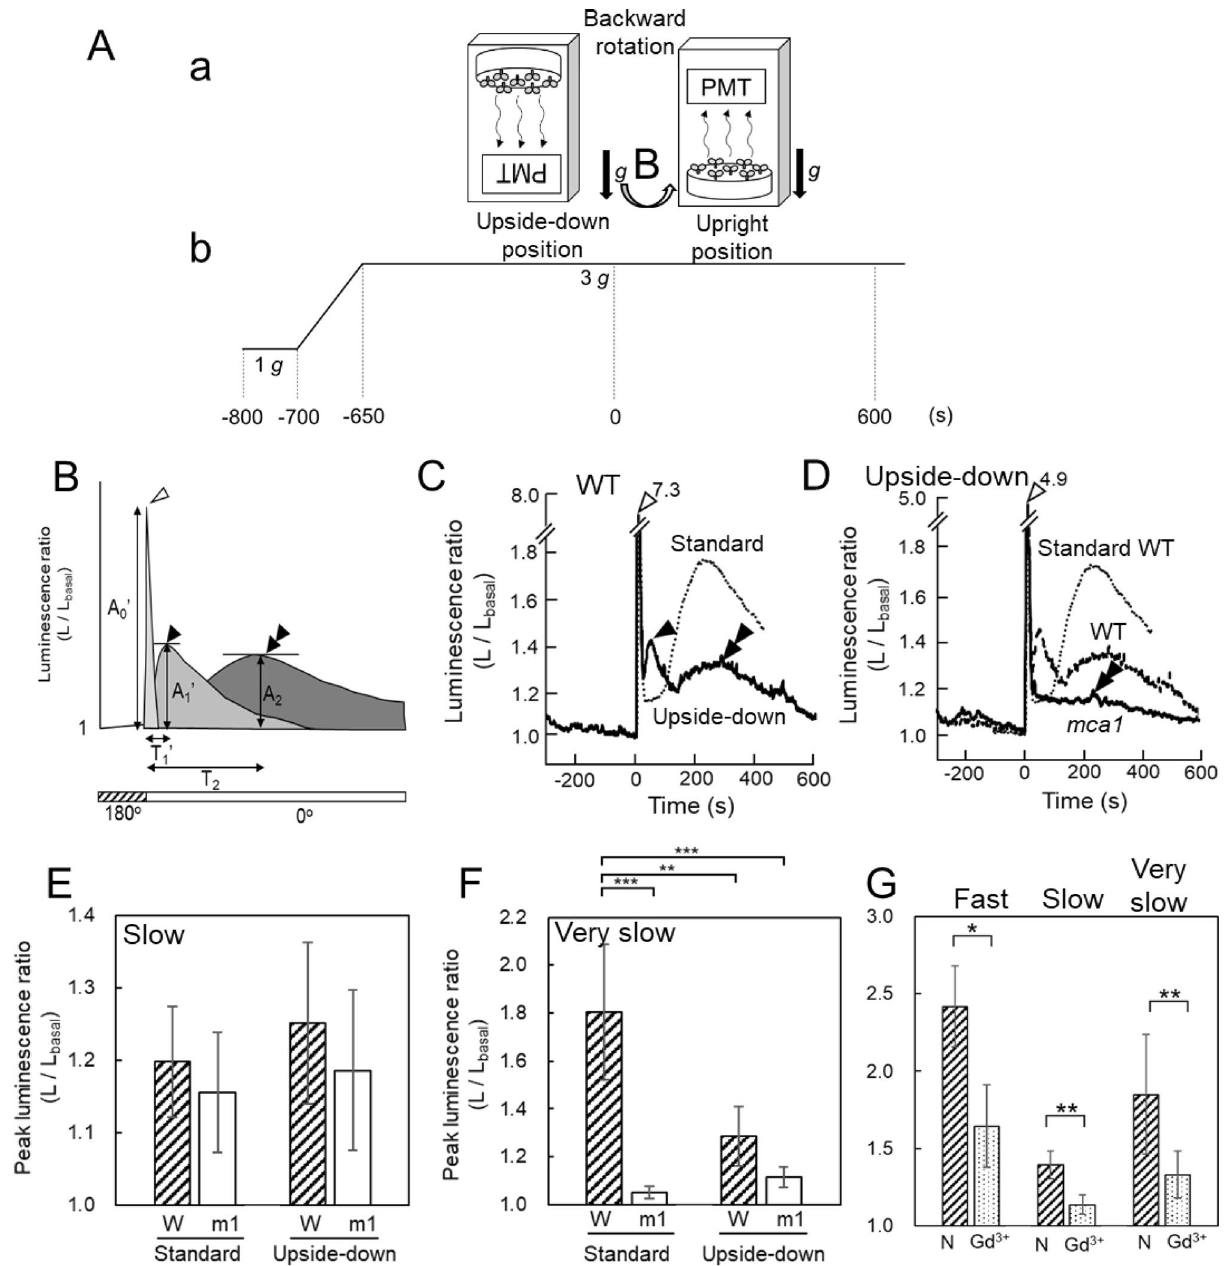
Figure 4. The very slow [Ca 2+ ] c -increase induced by backward rotation to the upright position in pre-rotated plants. A ( a ) The direction of Arabidopsis seedlings in the experimental protocol. ( b ) Time course of the magnitude of gravitational acceleration. The seedlings used for this experiment were kept in an upside-down position for 2–4 h prior to the experiment. ( B ) Schematic illustration of the time course of the change in the luminescence ratio induced by gravistimulation (backward rotation). The notation is the same as Fig. 1. ( C ) A typical [Ca 2+ ] c -increase induced by backward rotation under 3 g conditions in the wild-type seedlings, and the dotted lines show the mean time course of the slow and very slow [Ca 2+ ] c -increases by the standard protocol. ( D ) A typical [Ca 2+ ] c -increase in mca1 -knockout mutant seedlings induced by backward rotation under 3 g conditions, and the dotted lines shows the mean time course of the slow and very slow [Ca 2+ ] c -increases of preconditioned wild-type plants, and the time course of wild-type [Ca 2+ ] c -increase by standard protocol. ( E ) The amplitudes of the slow [Ca 2+ ] c -increase induced by backward rotation under 3 g conditions (A 1 ′ ). W: wild-type, m1: mca1 knockout, standard: the standard protocol, upside-down: the protocol shown in the panels A and B (seedlings were pre-rotated 2–4 h before the experiment). ( F ) The amplitudes of the very slow [Ca 2+ ] c -increase induced by backward rotation under 3 g conditions. ( G ) The amplitudes of fast [Ca 2+ ] c -increases (A 0 , “Fast”), slow [Ca 2+ ] c -increases (A 1 , “Slow”), and very slow [Ca 2+ ] c -increase (A 2 , “Very slow”) induced by backward rotation under 3 g conditions were decreased by Gd 3+ (100 μM). Data represent the mean ± SD. n = 3. Data represent mean ± SD. n = 4. * P < 0.05, ** P < 0.01, two-tailed Student’s